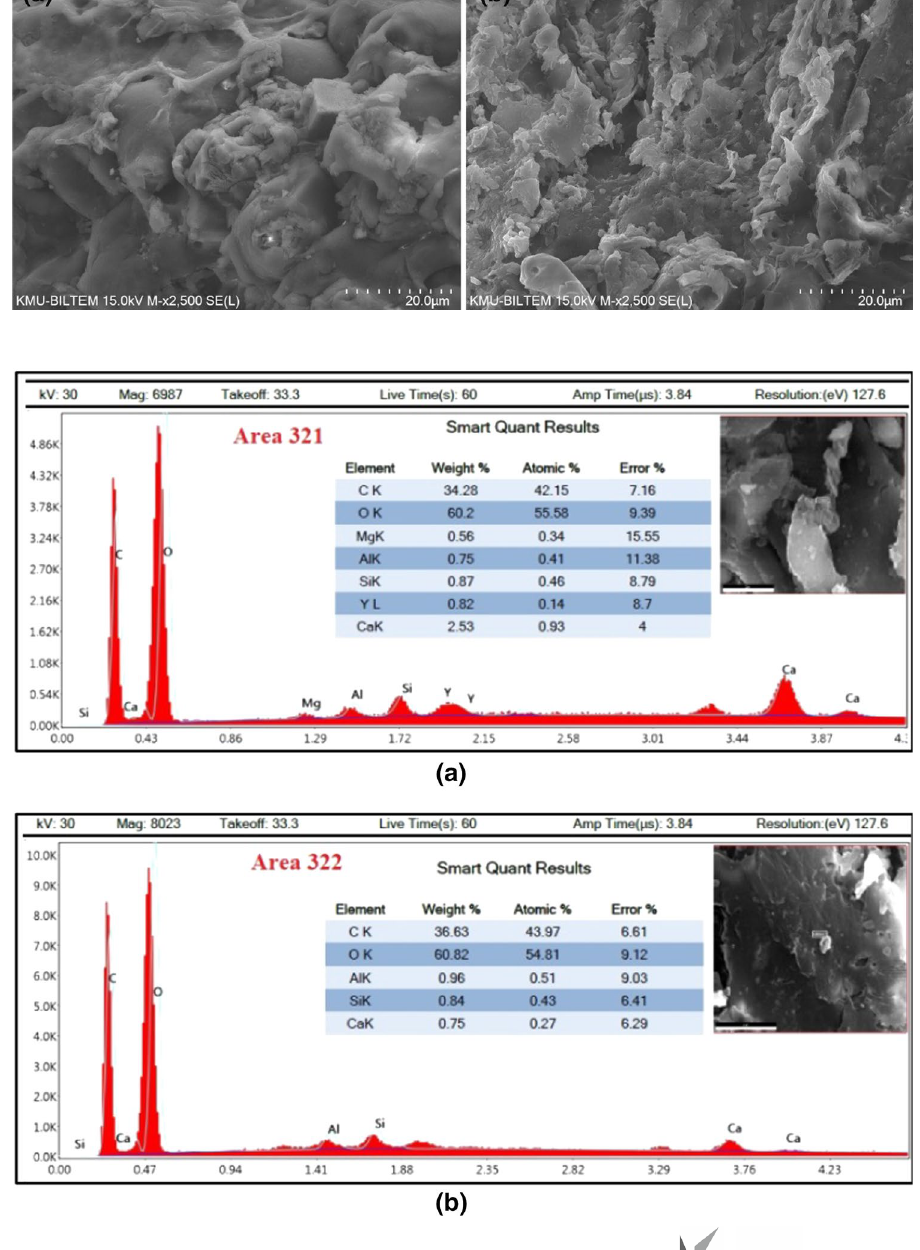
Fig. 5 SEM images of P raw and P-Cu adsorbent: